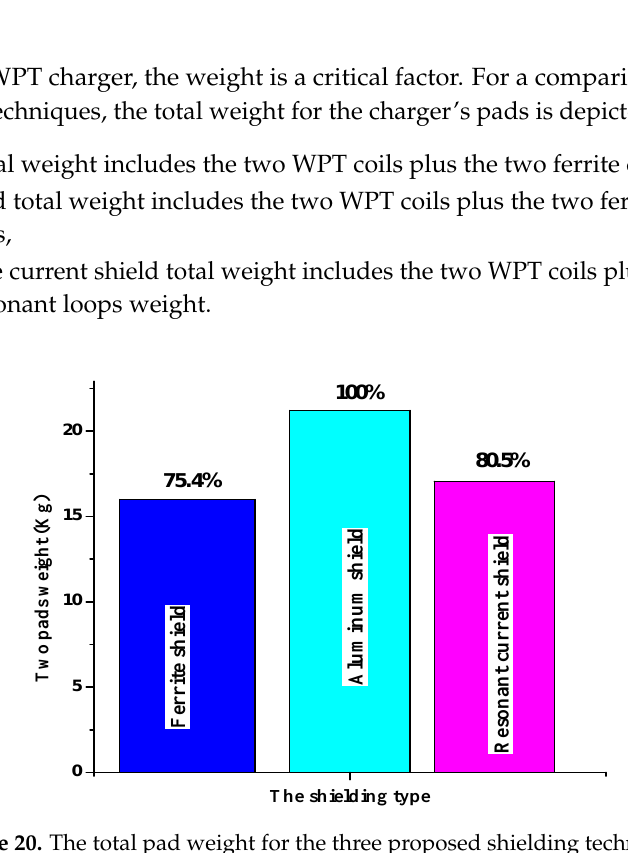
Figure 20. The total pad weight for the three proposed shielding